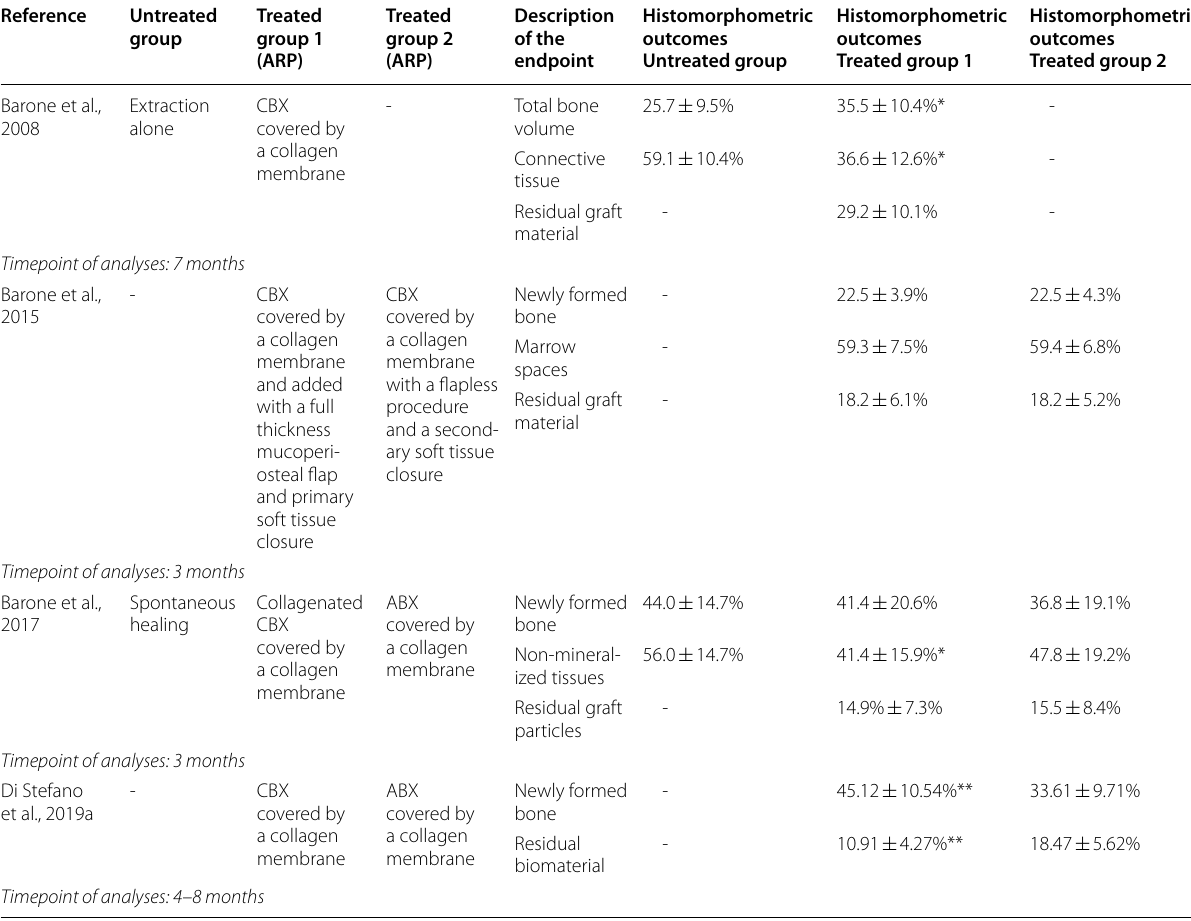
Table 5 Histomorphometric analysis on alveolar sockets grafted with CBXs for ARP. Data are presented as Mean percentages